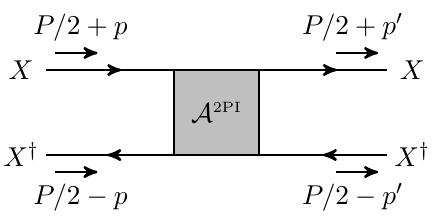
Figure 20 . Momentum decomposition of the 2PI diagrams of the XX y